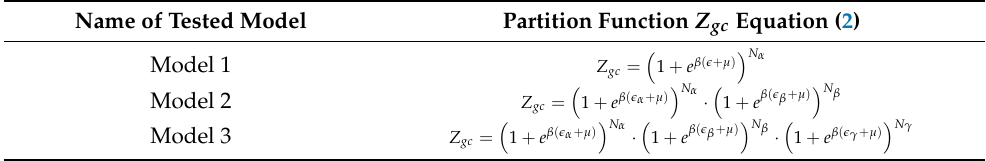
Table 1. Partition functions of the tested